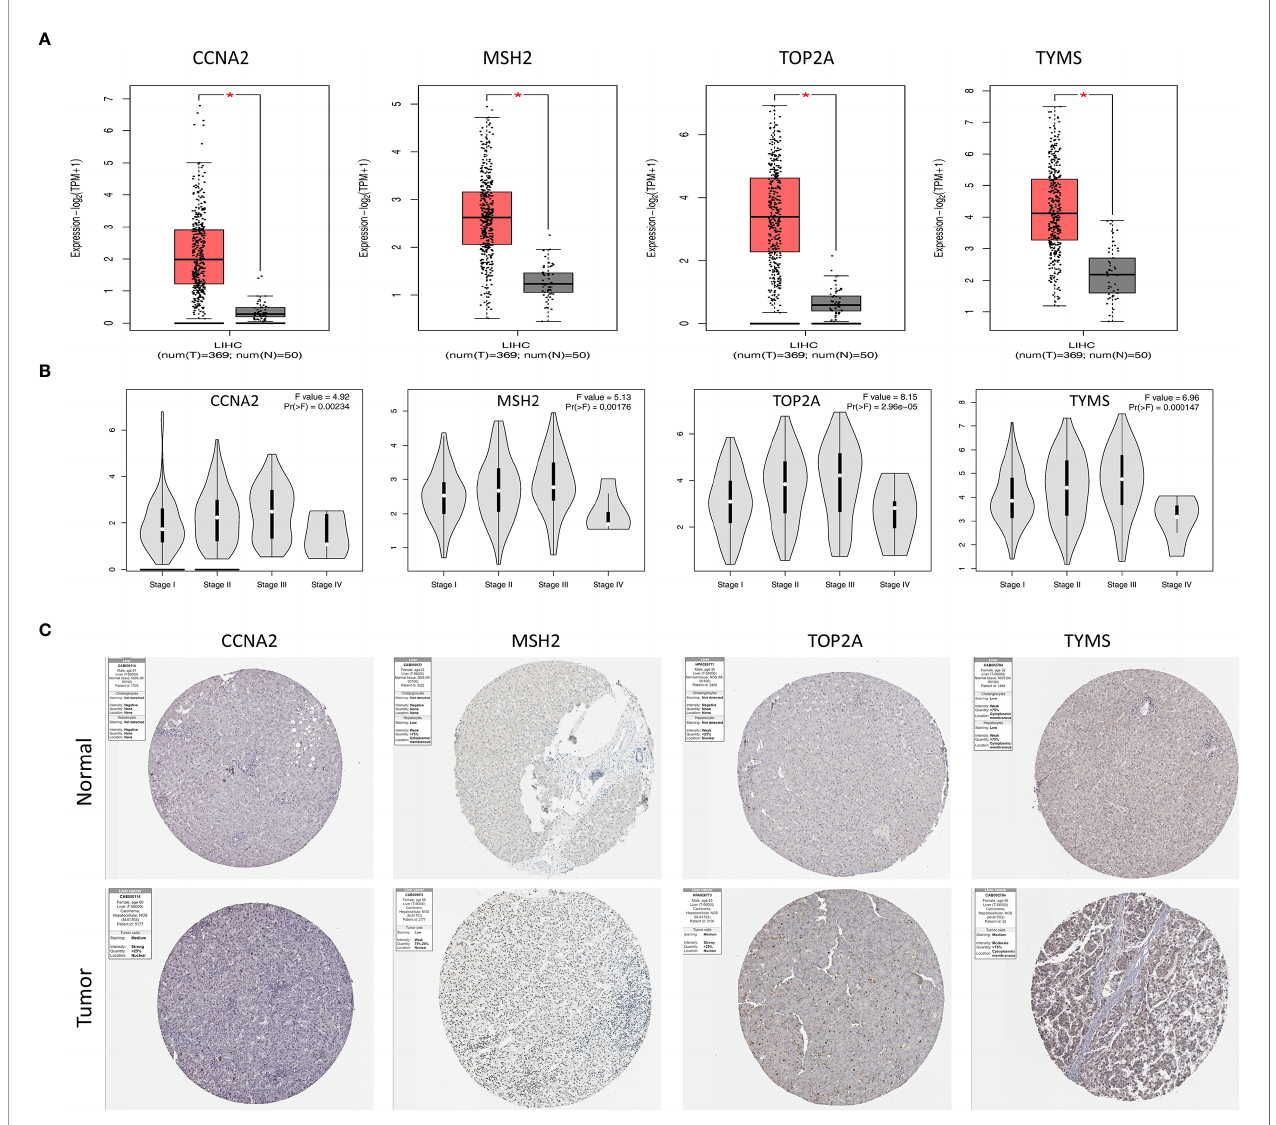
FIGURE 5 | Validation of genes expressions of four hub genes. (A) Box plots of CCNA2, MSH2, TOP2A and TYMS expression in TCGA tumor and normal tissues. (B) Correlations between differently expressed genes and the pathological TNM stage of HCC patients. (C) Representative immunohistochemistry staining of CCNA2, MSH2, TOP2A and TYMS in HCC tissue obtained from the Human Protein Atlas. *P <